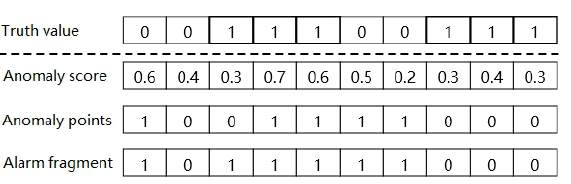
Figure 11. Fragment alarm for anomaly detection.